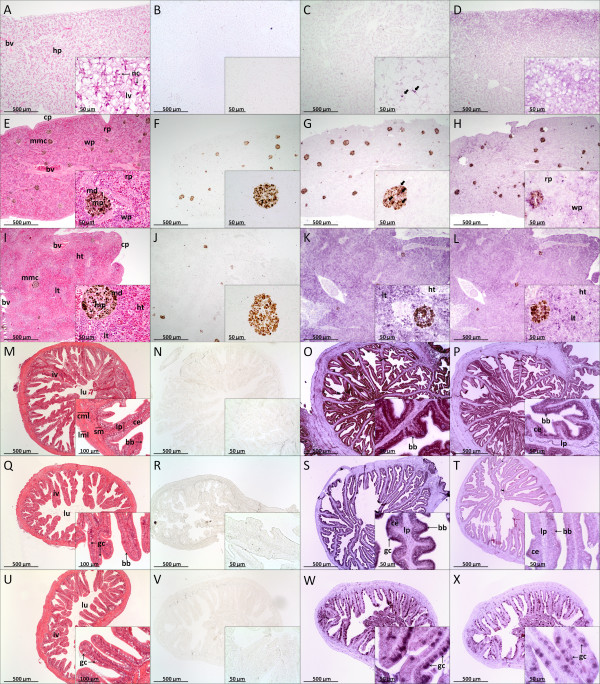
In situ hybridization. A to D - liver; E to H - spleen; I to L - head kidney; M to P - anterior intestine; Q to T - mid intestine; U to X - posterior intestine. 1st column - H&E staining; 2nd column - hybridization with sense probes (control); 3rd column - hybridization with slc11a2-α specific probe; 4th column - hybridization with slc11a2-β specific probe. cp - capsule; rp - red pulp; wp - white pulp; mmc - melanomacrophage center; bv - blood vessel; md - melanin deposits; mc - macrophages; lt - lymphomyeloid tissue; ht - hematopoietic tissue; hp - hepatocytes; lv - lipidic vacuole: nc - nuclei; iv - intestinal villi; lu - lumen; lml - longitudinal muscle layer; cml - circular muscle layer; sm - submucosa; lp - lamina propria; ce - columnar epithelium; bb - brush border; gc - goblet cells. Thick arrows indicate points of slc11a2-α presence.